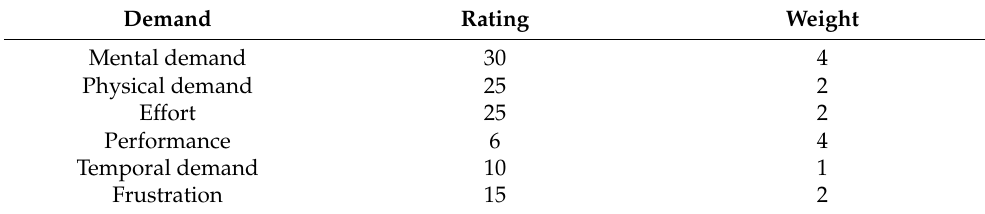
Table 3. NASA–TLI